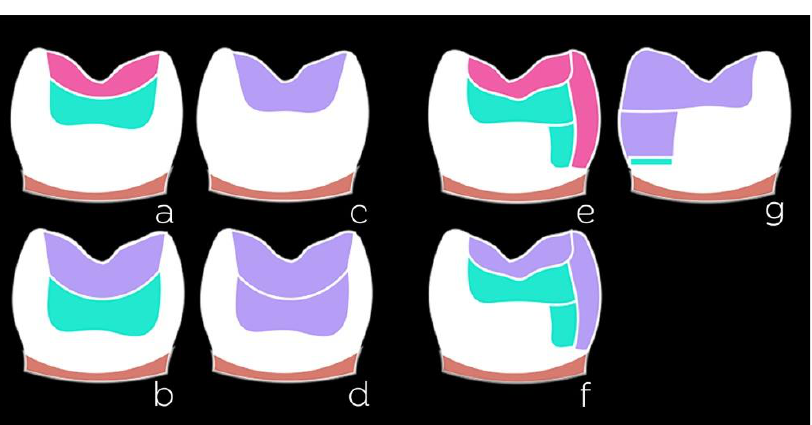
Figure 7. Different restorative strategies using bulk-fill resin composites. Green = flowable bulk-fill composite; Pink= conventional composite; Purple= regular bulk-fill composite. Reconstruction of the dentin portion with flowable bulk-fill composite and a conventional composite as the last layer ( a ). Reconstruction of the dentin portion with flowable bulk-fill composite and regular bulk-fill composite as the last layer for deeper cavities ( b ). Cavities that respect the limit of the composite polymerization depth can be restored with a single increment of regular bulk-fill composite ( c ). Deeper cavities can be restored with two increments of regular bulk-fill composite ( d ). Class II cavities can be restored with conventional composite emulating the enamel and its interior filled with flowable bulk-fill composite for dentin reconstruction. Similar to example ( e ), a regular bulk-fill composite can be used for the enamel ( f ). It is also possible to use flowable bulk-fill composite as a liner on the gingival wall for all techniques described here. Two increments of a larger volume of regular bulk-fill composite added above a liner with flowable bulk-fill composite ( g ).